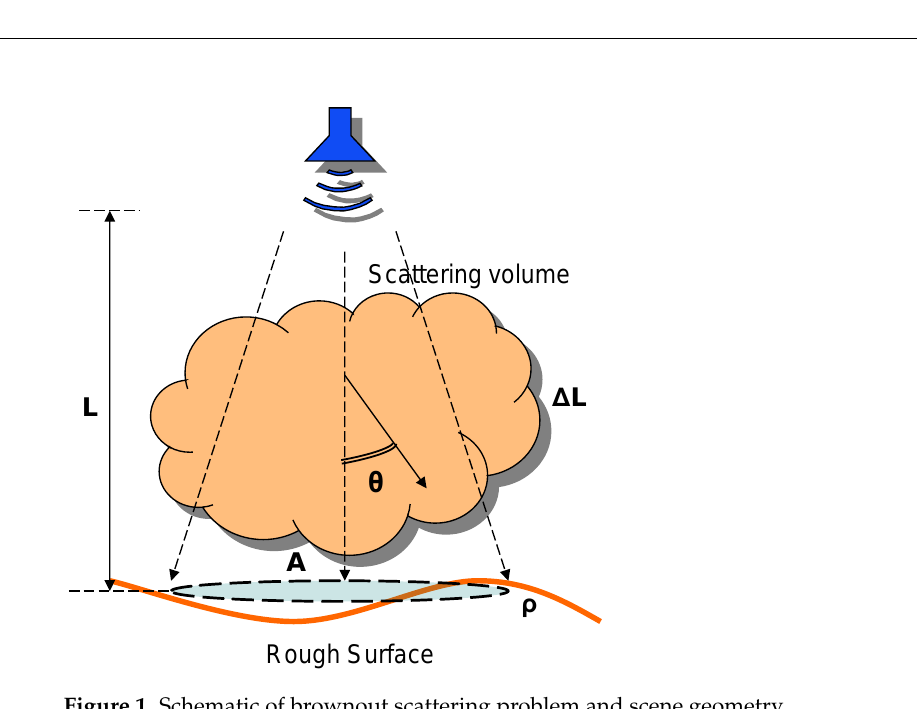
Figure 1. Schematic of brownout scattering problem and scene geometry.